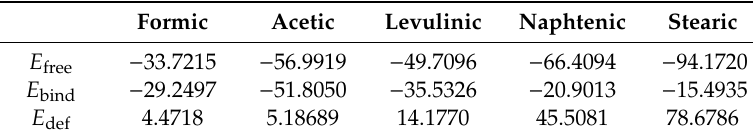
Table 2. The deformation energies of acid molecules (kcal / mol). Formic Acetic Levulinic Naphtenic Stearic E